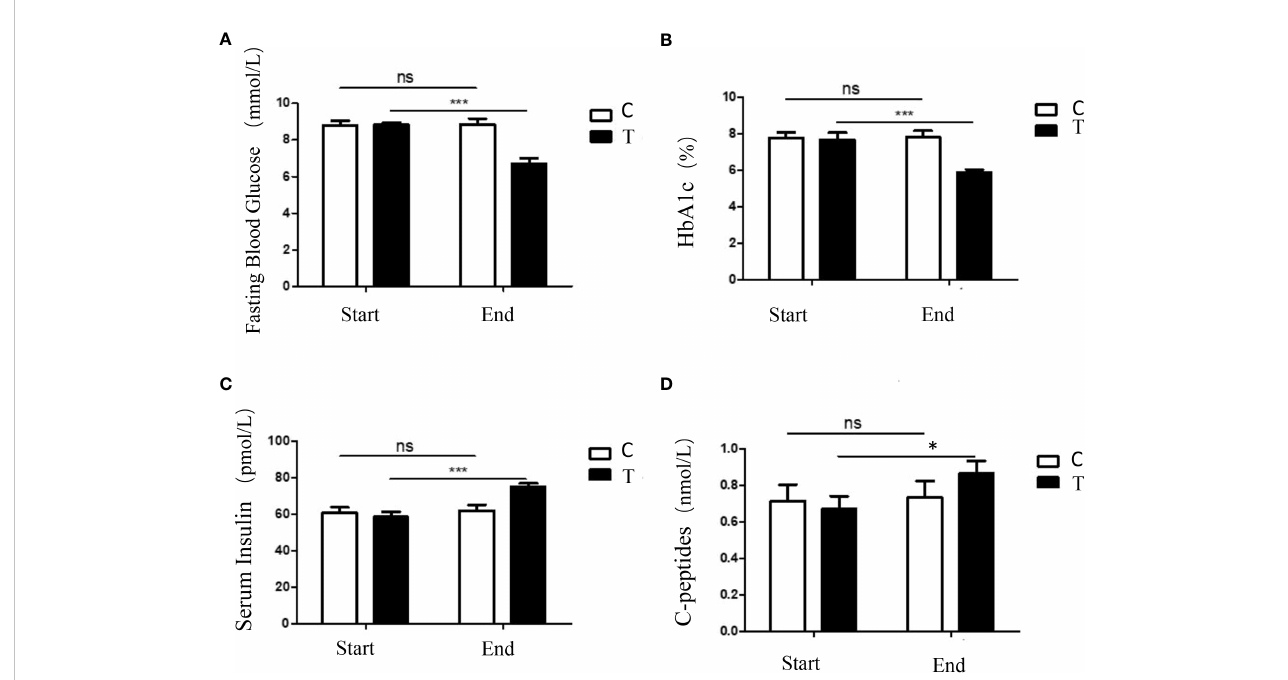
FIGURE 1 A high- fi ber diet improved the glucose homeostasis in participants with T2DM. Changes in fasting blood glucose (A) , the percentage of HbA1c (B) , serum insulin (C) , and C-peptides (D) of the participants during the intervention were shown. The symbols * indicates p< 0.05, symbols*** indicates p< 0.001, ns indicates no signi fi cant